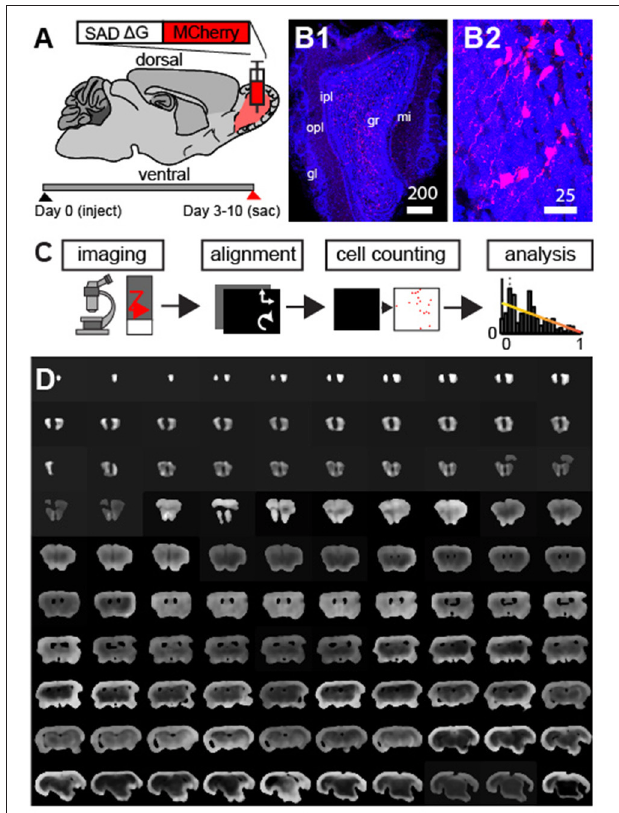
FIGURE 1 | Modified g-deleted rabies tracing to identify feedback projection to the olfactory bulb. (A) Schematic outlining experimental design. (B1) Neurons labeled with mCherry rabies (red) and DAPI nuclear counter-stain (blue) at the injection site. Scale bar = 200 um. mi, mitral cell layer; opl, outer plexiform layer; ipl, inner plexiform layer; gl, glomerular layer; gcl, granule cell layer. (B2) Enlargement of neurons in (B1) shows clearly labeled neurons in the GCL. (C) Outline of approach involves automated fluorescence microscopy, coronal section alignment, automated cell counting, and subsequent analysis. (D) Example of coronal sections used for whole brain reconstructions.